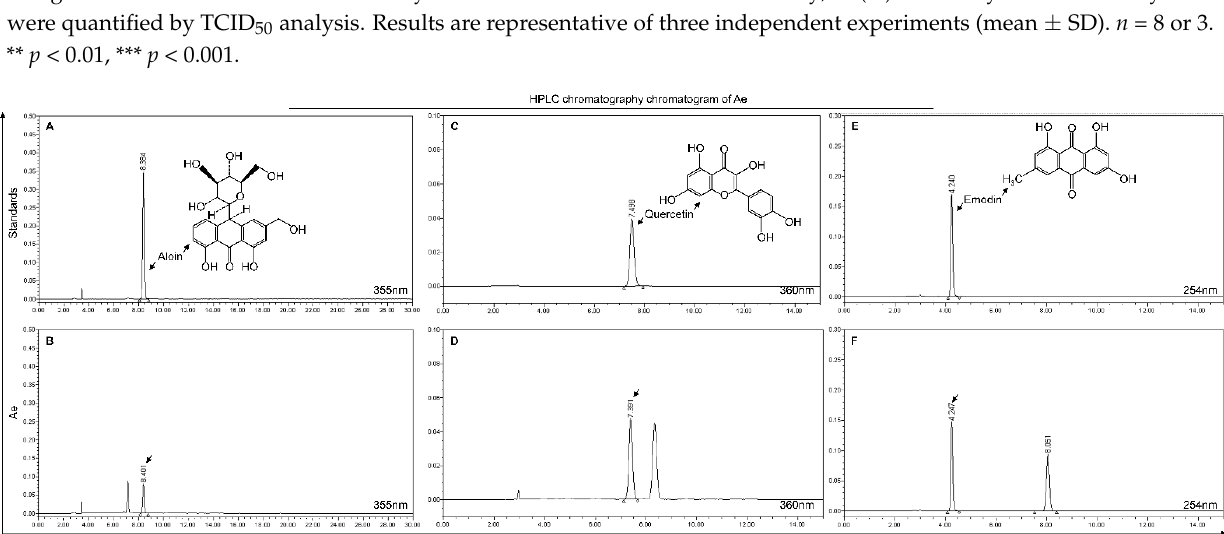
Figure 2. HPLC chromatography chromatogram of Ae. Detection at wave length 355 nm for Aloin from reference standard or Ae ( A , B ). Detection at wave length 360 nm for Quercetin from reference standard or Ae ( C , D ). Detection at wave length 254 nm for Emodin from reference standard or Ae ( E , F ).